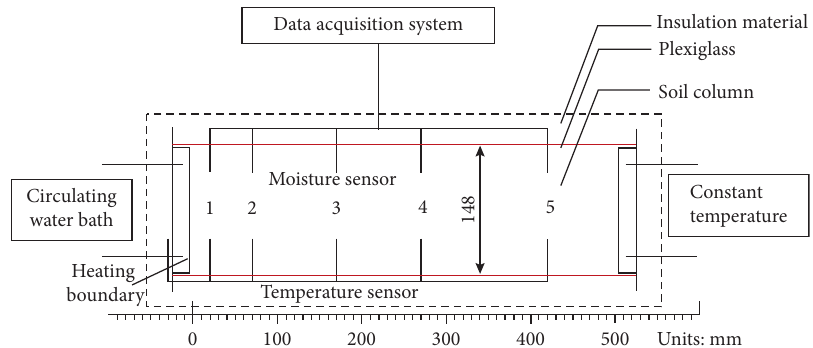
Figure 1: Experimental apparatus (half of the